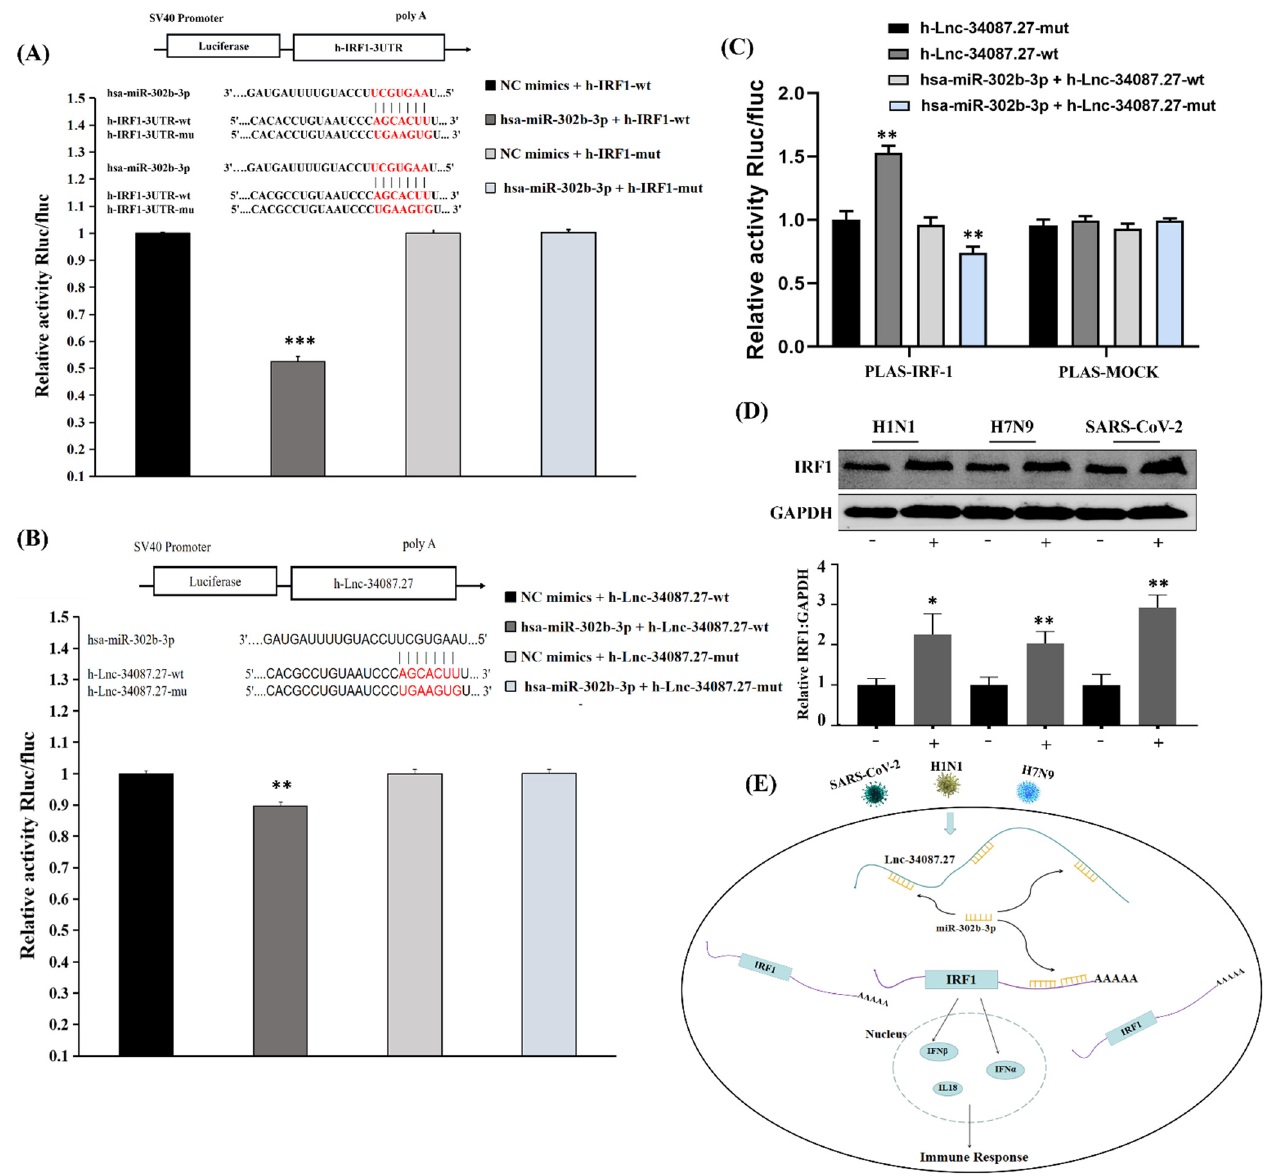
Figure 8. LncRNA-34087.27 upregulates IRF1 expression by acting as a competitive endogenous RNA. ( A ) Relative activity of Rluc/fluc in HEK293T cells cotransfected with miR-302b-3p and IRF1 3 ′ -UTR. “***” represents p < 0.001. ( B ) Relative activity of Rluc/fluc in HEK293T cells cotransfected with miR-302b-3p and lncRNA-34087.27. “**” represents p < 0.01. ( C ) Relative activity of Rluc/fluc in HEK293T cells cotransfected with IRF1 and lncRNA-34087.27, lncRNA-34087.27-mut, lncRNA- 34087.27 + miR-302b-3p, or lncRNA-34087.27-mut + miR-302b-3p. “**” represents p < 0.001. ( D ) The protein expression of IRF1 after SARS-CoV-2, panH1N1, and H7N9 infection. “*” represents p < 0.05 and “**” represents p < 0.01. ( E ) Summary of the potential mechanisms of a competitive endogenous RNA network that affects the immune responses in SARS-CoV-2-, panH1N1-, and H7N9-infected cells.